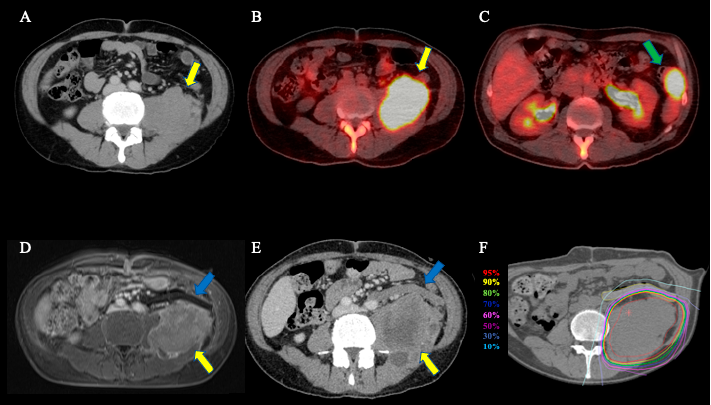
Figure 1. Radiological images before C-ion RT and dose distribution. ( A ) Contrast-enhanced CT. The yellow arrow reveals the tumor. ( B ) FDG-PET/CT. The yellow arrow reveals the tumor with an abnormal FDG uptake (standardized uptake value max = 32.67). ( C ) FDG-PET/CT. The green arrow presents the sub nodule with an abnormal FDG uptake (standardized uptake value max = 8.98). ( D ) CT images after the spacer placement. The yellow arrow reveals the tumor, and the blue arrow presents the spacer. ( E ) Contrast-enhanced magnetic resonance image of the spacer placement. The yellow arrow reveals the tumor, and the blue arrow shows the spacer. ( F ) Dose distribution on axial CT images. The area within the red outline is the tumor. Highlighted are the 95% (red), 90% (yellow), 80% (green), 70% (deep blue), 60% (magenta), 50% (purple), 30% (blue), and 10% (light blue) isodose curves (100% was 70.4 Gy (RBE)).